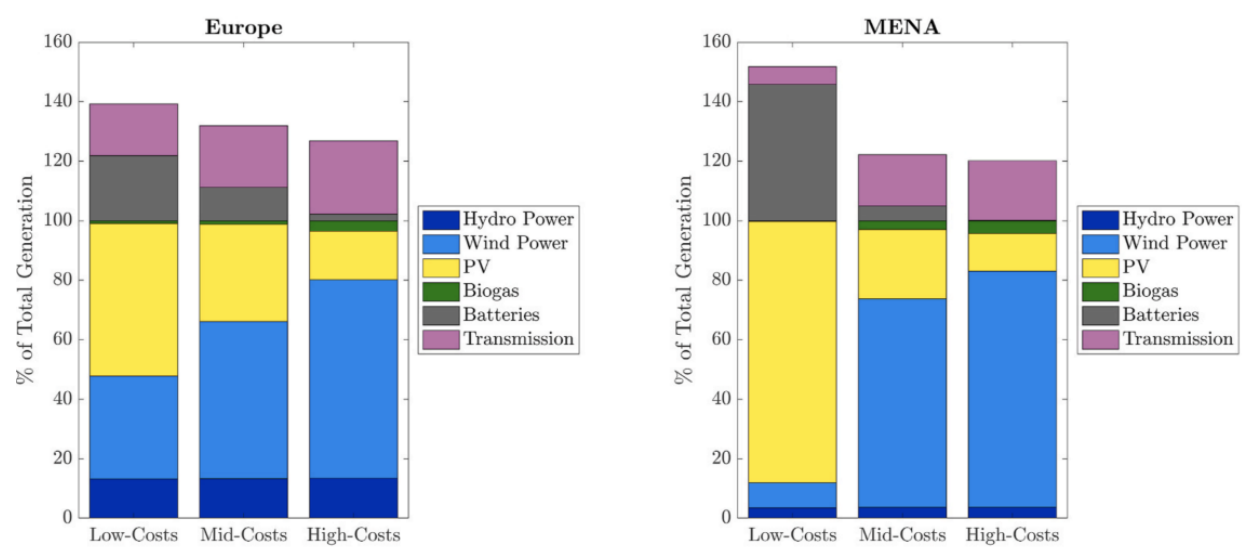
Figure 13. Total installed cost for small hydropower plants by country/region, 2010–2020 [82].